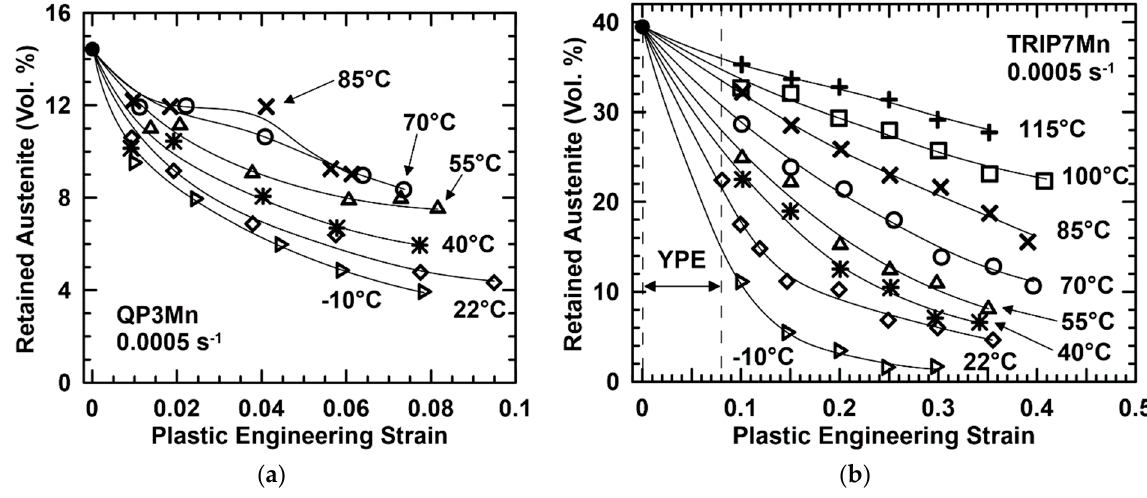
Figure 4. Austenite volume fraction versus plastic strain from tests at 0.0005 s − 1 and various temperatures for ( a ) QP3Mn and ( b ) TRIP7Mn.